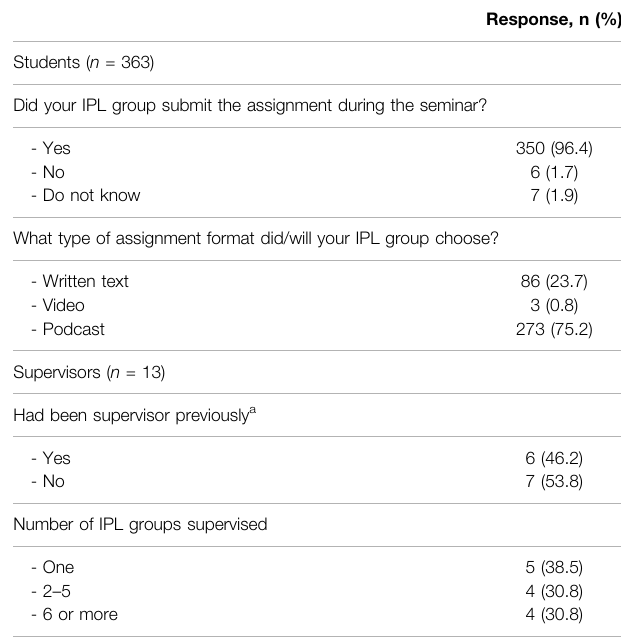
TABLE 2 | The choice of and experience with the assignment format among students and